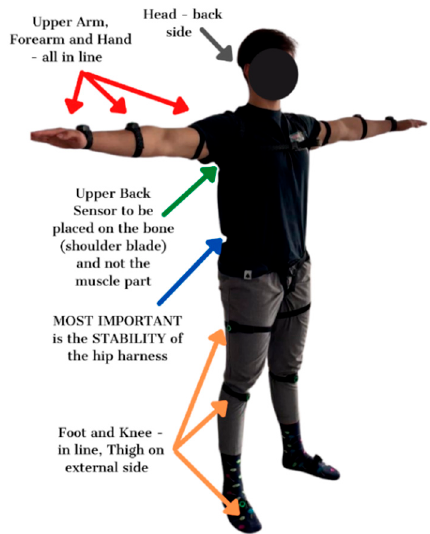
Figure 5. The correct fit of the MoCap suit .